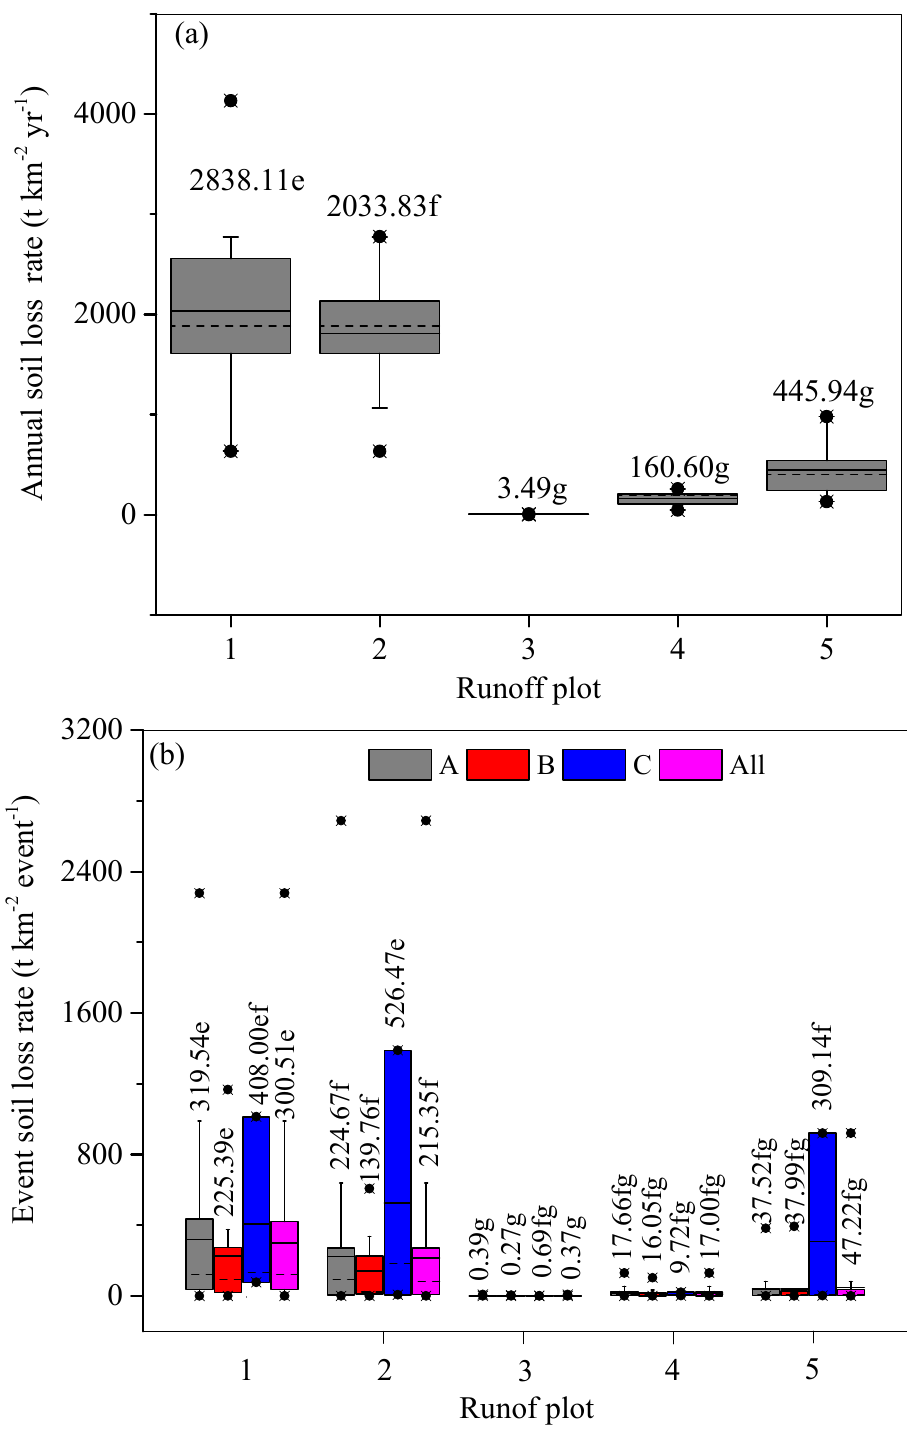
Figure 5. Annual soil loss rate ( a ) and event soil loss rate ( b ) for the 85 rainfall events under each rainfall regime. Note: Average values on the columns with the same letter are not significantly different at the 0.05 level. The solid line in the box represents the mean value, and the dotted line represents the median value.